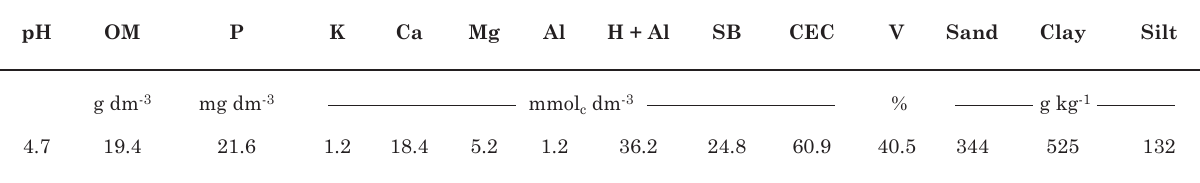
table 1. Soil chemical and particle size properties in the 0.00–0.20 m layer